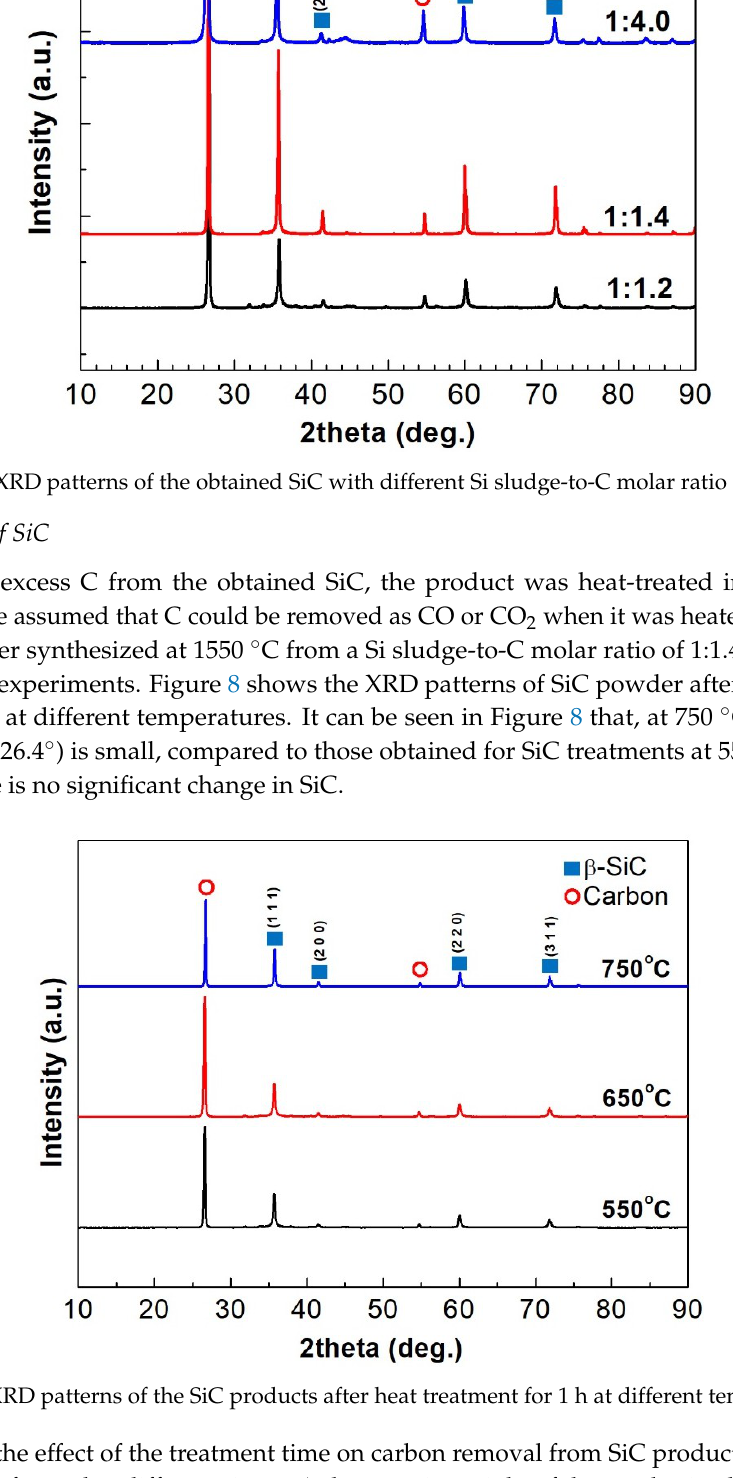
Figure 8. XRD patterns of the SiC products after heat treatment for 1 h at different temperatures.